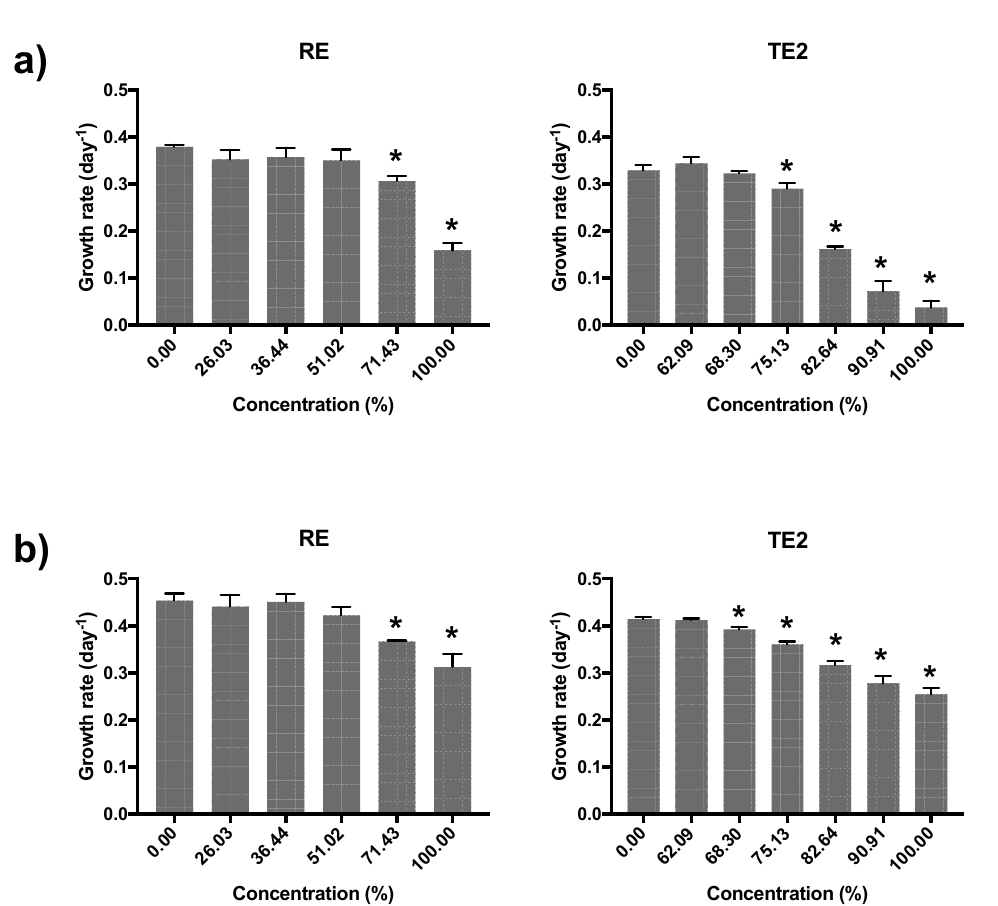
Figure 2. Average growth rate (day − 1 ) of L. minor based on the frond number ( a ) and the dry biomass ( b ) exposed to different dilutions of the effluent. Error bars represent the standard deviation of the mean (n = 3); asterisks indicate statistically significant differences from the control (Dunnett’s test p < 0.05).